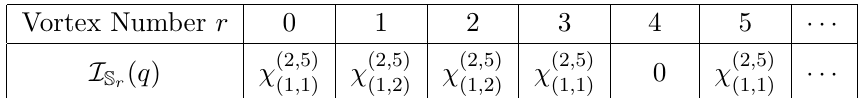
Table 1 . The vortex surface defect indices in the Schur limit for the A 2 Argyres-Douglas theory. (cid:31) (2 ; 5) and (cid:31) (2 ; 5) denote the characters of the vacuum and the h = (cid:0) 1 = 5 primary, respectively. The (1 ; 1) (1 ; 2) defect Schur index in this case is periodic in the vortex number r with period 5. It also enjoys a re(cid:13)ection symmetry (cid:22) r $ 3 (cid:0) (cid:22) r , where (cid:22) r (cid:17) r mod